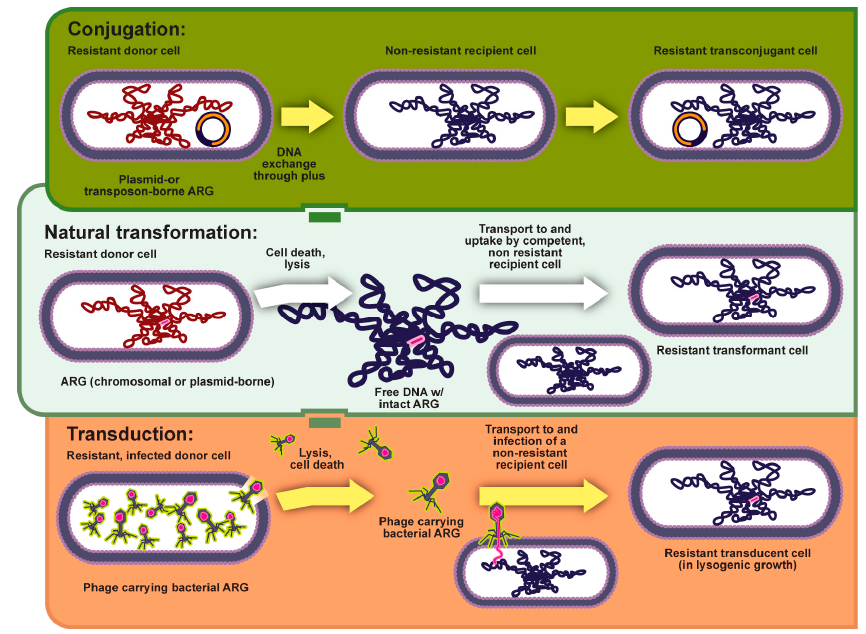
Figure 2. Horizontal gene transfer can commonly occur through conjugation and natural transformation. Additionally, it may occur through transduction, where resistance is transmitted via